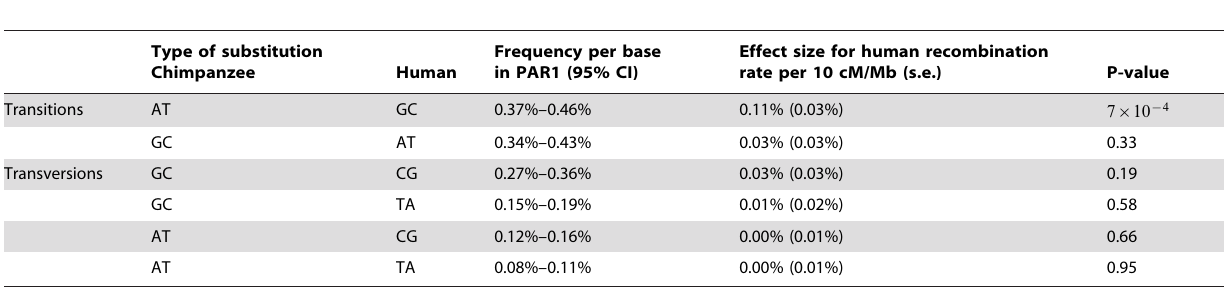
Table 1. Results of predicting divergence rate of different types of substitutions from human recombination rate, after regressing out effects of GC content, CpG content and the divergence rate of other types of substitutions in unique DNA.